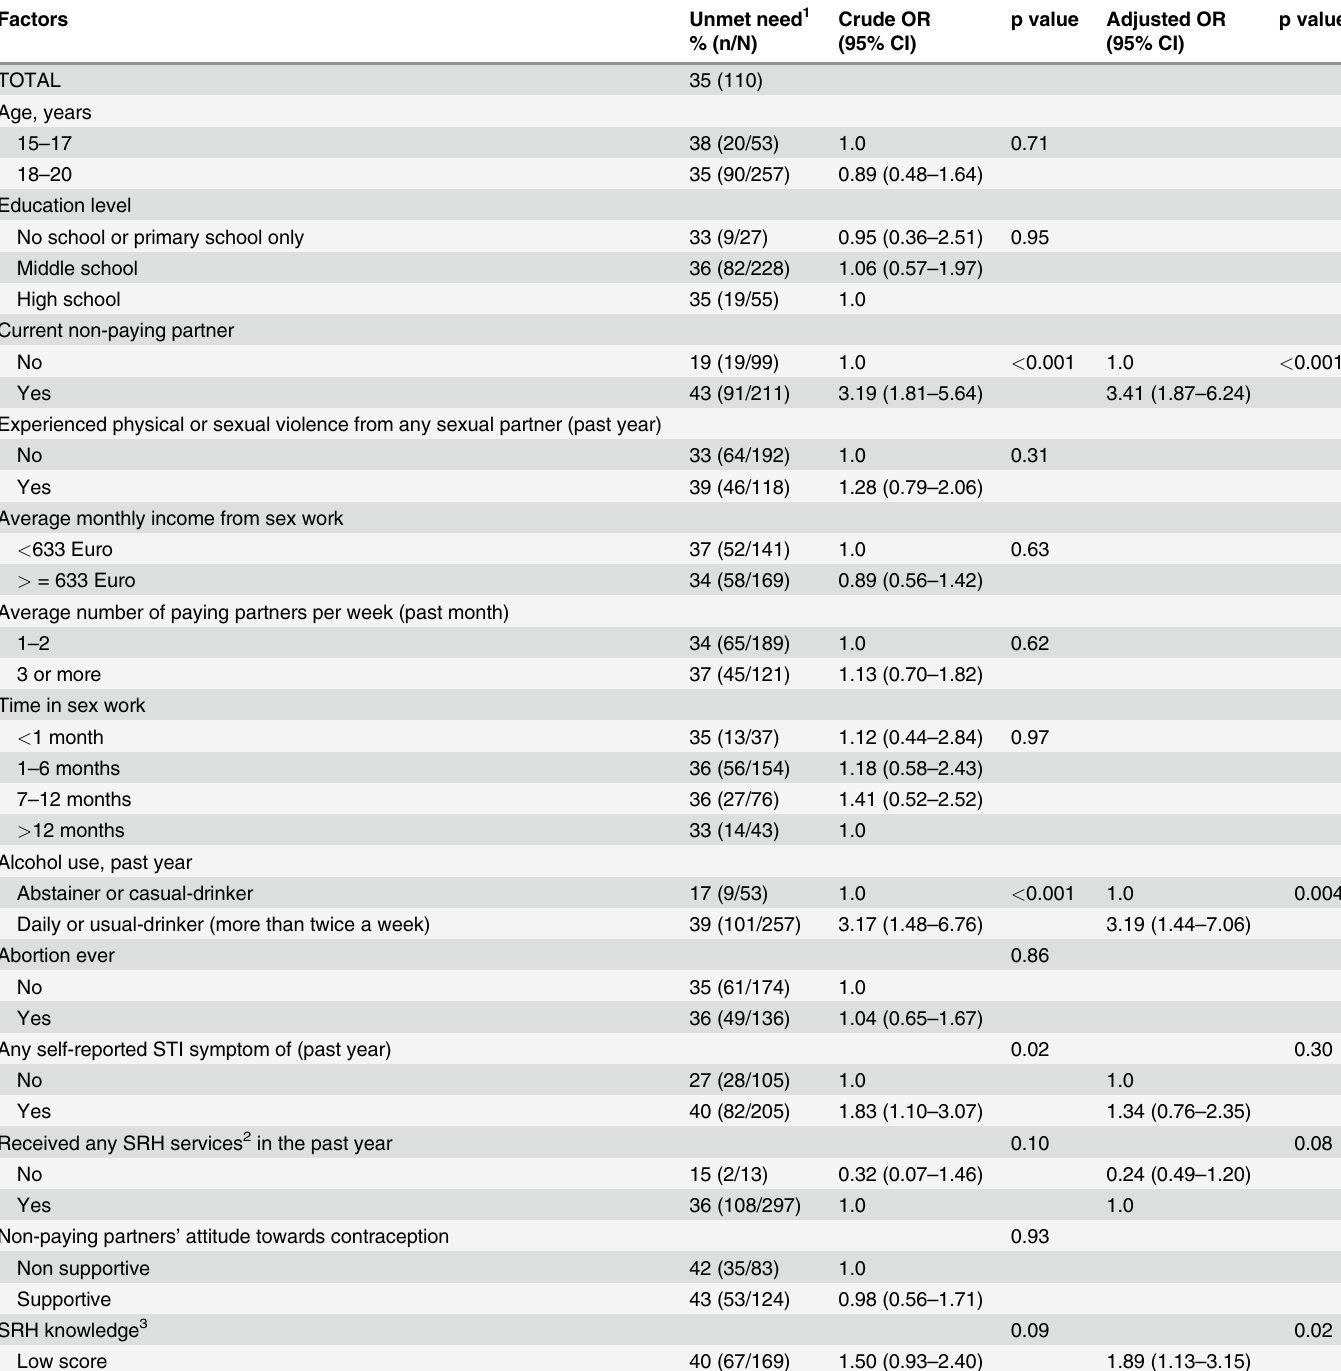
Table 5. Factors associated with current unmet need for modern contraception 1 among adolescent female sex workers (N = 310).